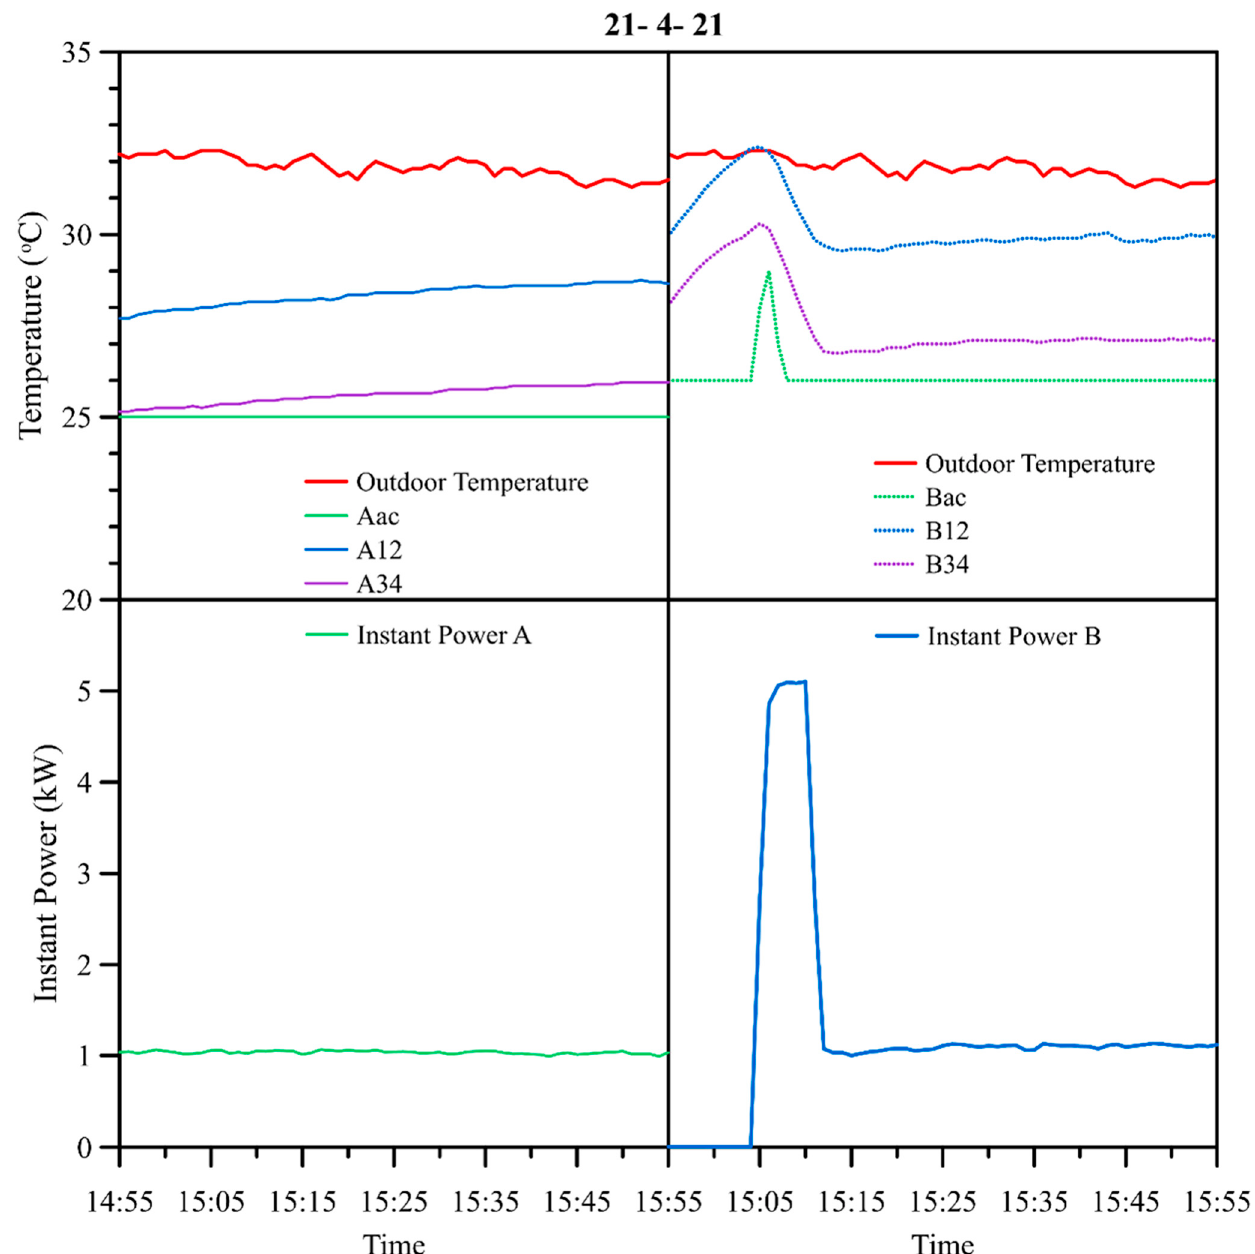
Figure 10. Temperature and instant power consumption of rooms A and B at 15 to 16. Figure 9 is at the deactivation in the early afternoon (12:00–13:00), which the sun started when entering the rooms. In room A, the air conditioner regulated the temperature of the sensor (Aac) within a 1 ◦ C fluctuation. Meanwhile, the room temperatures A1–A4 were separated into two groups by the distance from the window, as